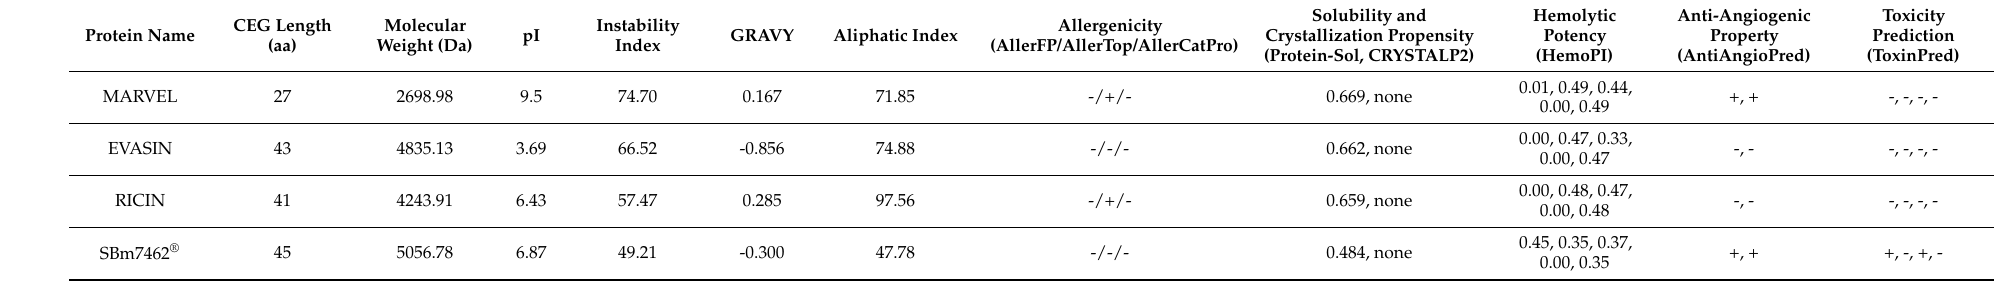
Table 3. Physicochemical properties of the selected overlapping coincident epitopes groups (CEGs) from MARVEL, EVASIN, and RICIN. “+” represents high probability, “-“ represents low